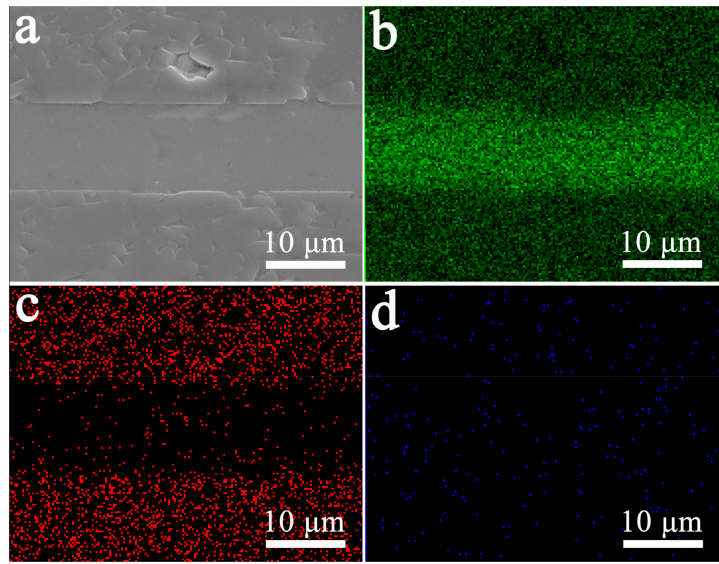
Figure 6. The joint SEM images of the Al 2 O 3 ceramic sample without Al film brazed at 700 ◦ C ( a ) and corresponding area-scan images of Al ( b ), O ( c ) and Cu ( d )